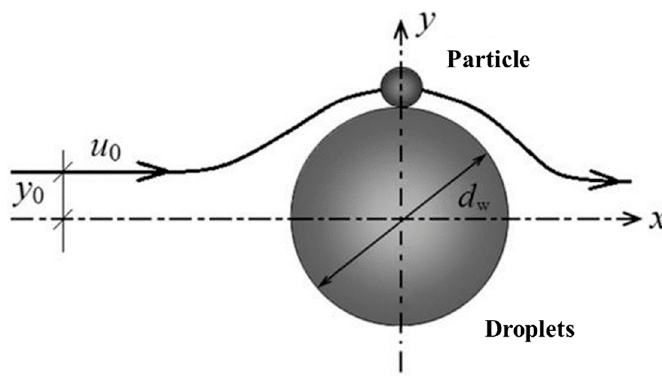
Figure 2. Schematic diagram of droplet trapping particles [44].